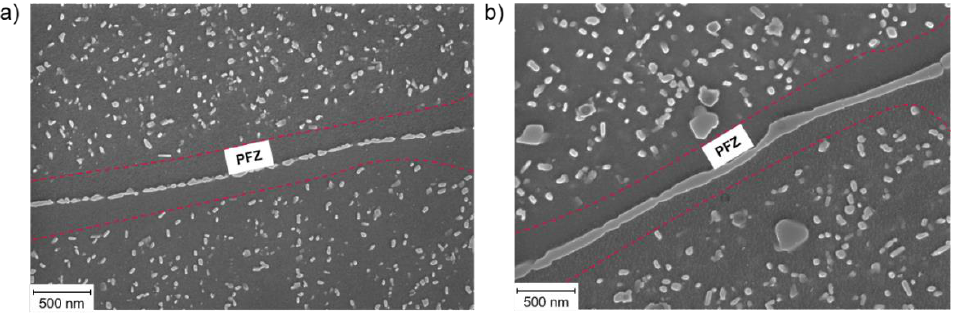
Figure 9. Laves phase particles in LMD-manufactured HiperFer AM : ( a ) LPD and ( b ) HPD variants.